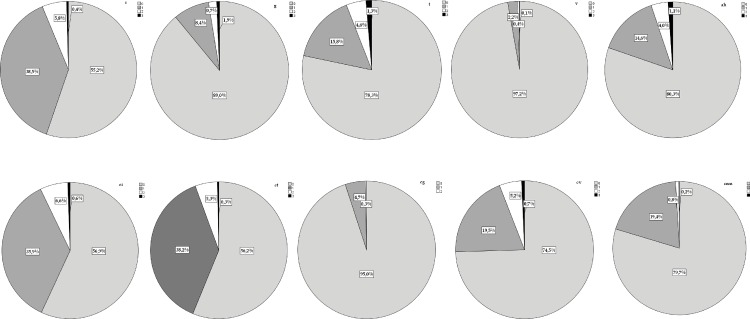
Frequency of the lesions diagnosed in PB.